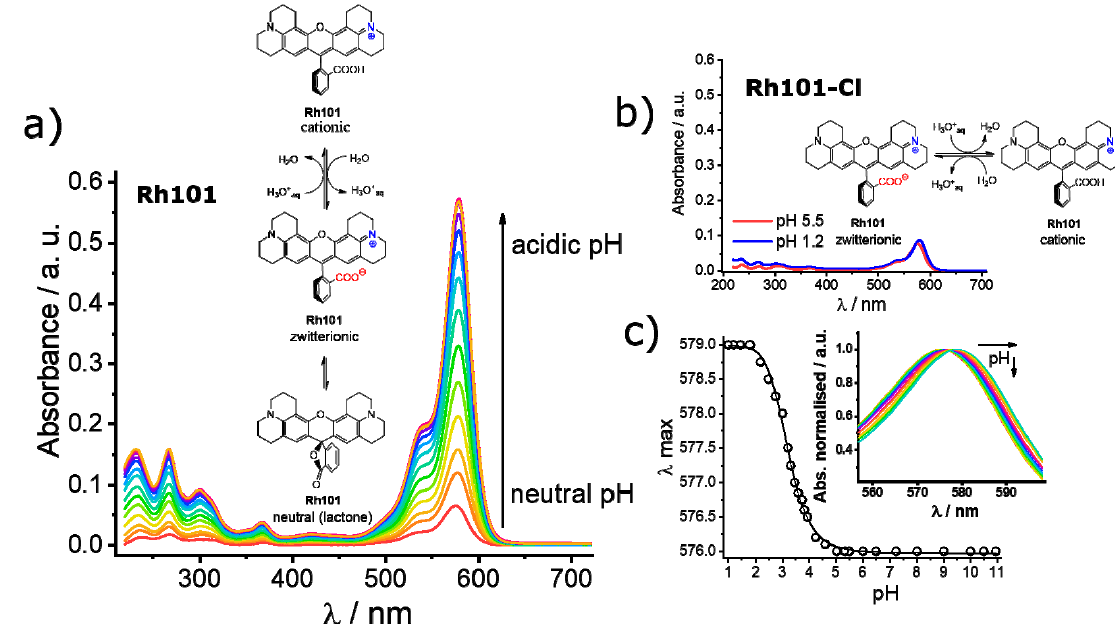
Figure 5. Absorbance registered upon pH titration of rhodamine 101 inner salt ( Rh101 ) ( a ) and rhodamine 101 chloride ( Rh101-Cl ) ( b ) in water. Inset: conversion equilibria of the different forms from the neutral and/or zwitterionic form to the cationic form under acidic pH values. ( c ) Maximum of wavelength registered as a function of the pH for the Rh101-Cl in water. Inset: zoomed normalised absorption titration spectra of Rh101-Cl , showing the bathochromic displacement of the maximum of the band from 576 to 579 nm.